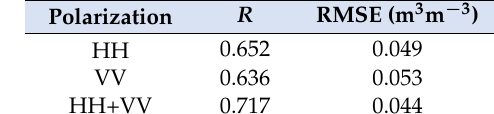
Figure 9. Scatterplots of in-situ soil moisture and soil moisture retrieved from the HH+VV, HH, and VV Polarizations. Table 5. Error metrics of soil moisture data retrieved from different polarizations.